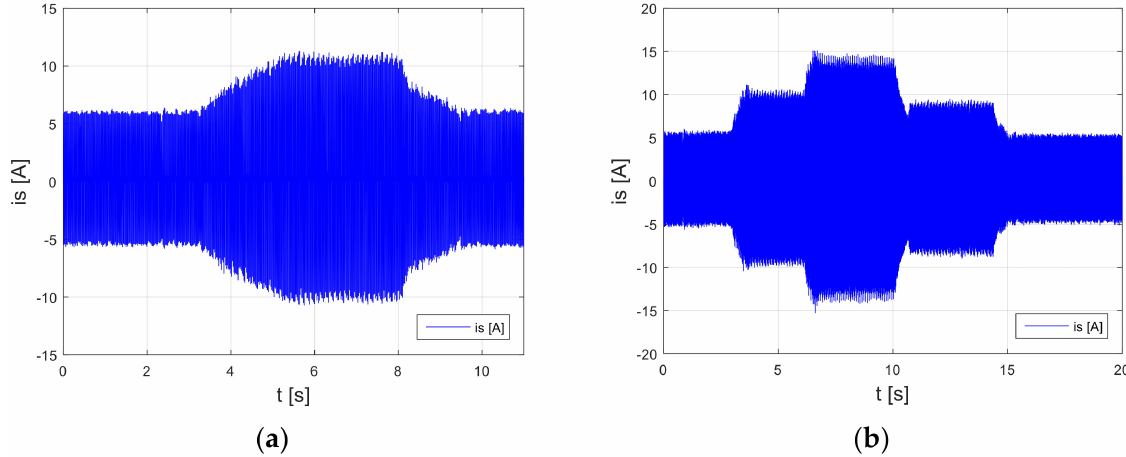
Figure 21. Waveforms of the converter input current: ( a ) Single speed ramp; ( b ) Double speed ramp.